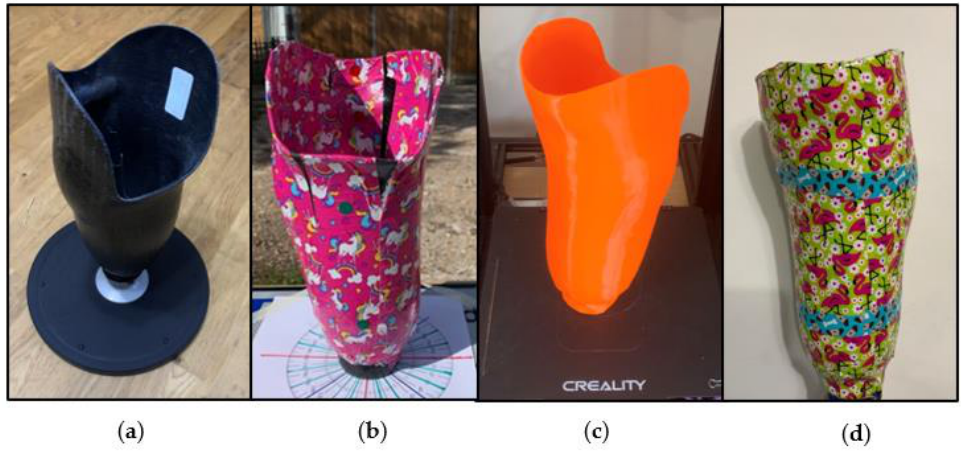
Figure 1. Socket and model preparation stages: ( a ) socket; ( b ) taped socket; ( c ) 3D printed control socket; ( d ) taped 3D printed control socket.